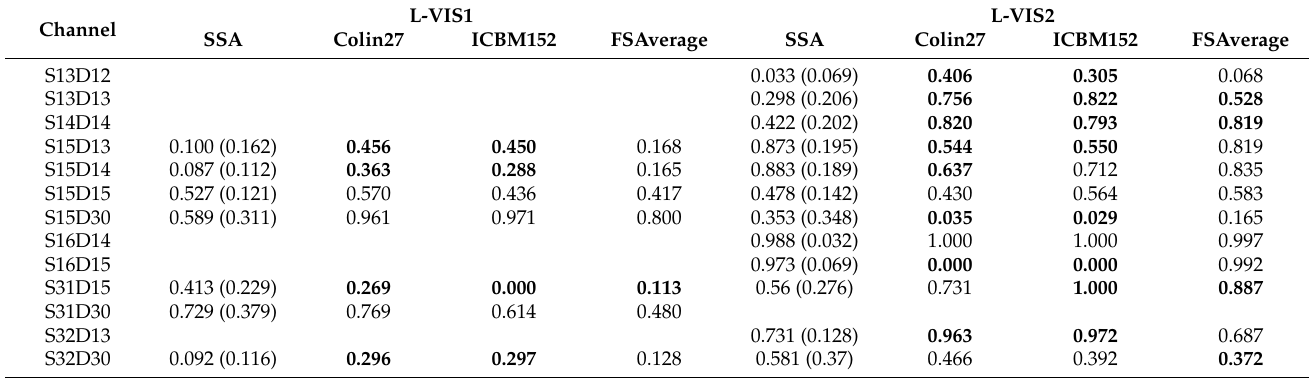
Table 8. Summary of A2Ch coefficients associated to selected left hemisphere functional ROIs: primary (VIS1) and secondary visual network (VIS2). Results are reported for wavelength λ = 760 nm. Bold ABA values indicate channels presenting a 20% difference in A2Ch coefficients from the SSA